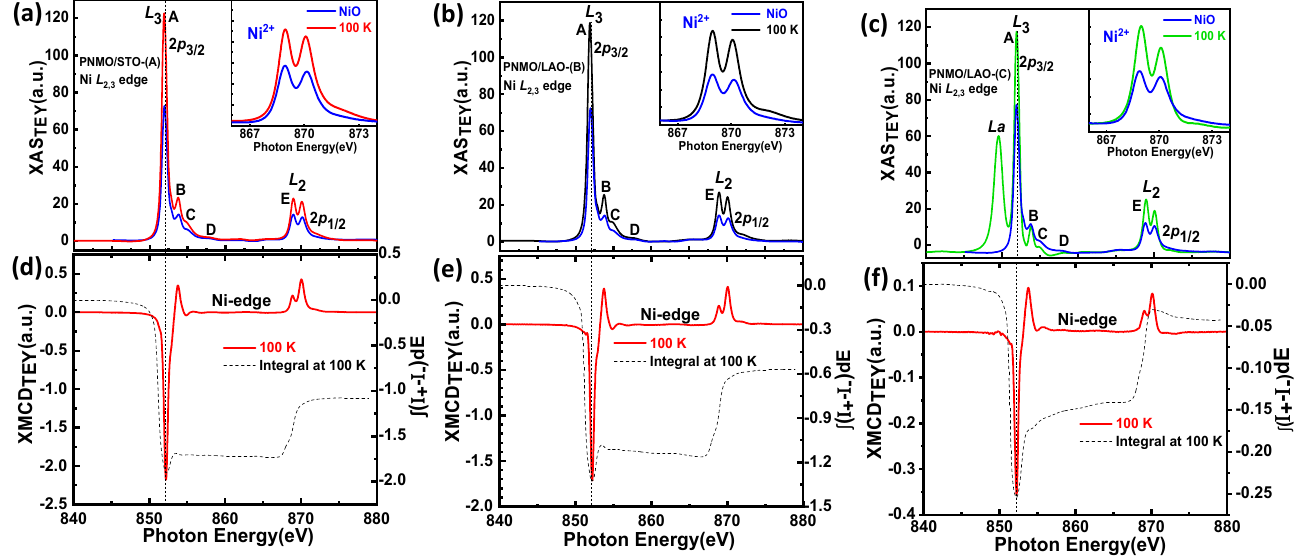
Figure 5. Experimental XAS spectra at Ni- L 2,3 edges for ( a ) PNMO/STO-(A), ( b ) PNMO/LAO-(B), and ( c ) PNMO/LAO-(C). The NiO XAS (blue curve) is also plotted for comparison. The corresponding XMCD signals at 100 K are plotted in ( d – f ) panels. Dashed black lines show the XMCD integral.